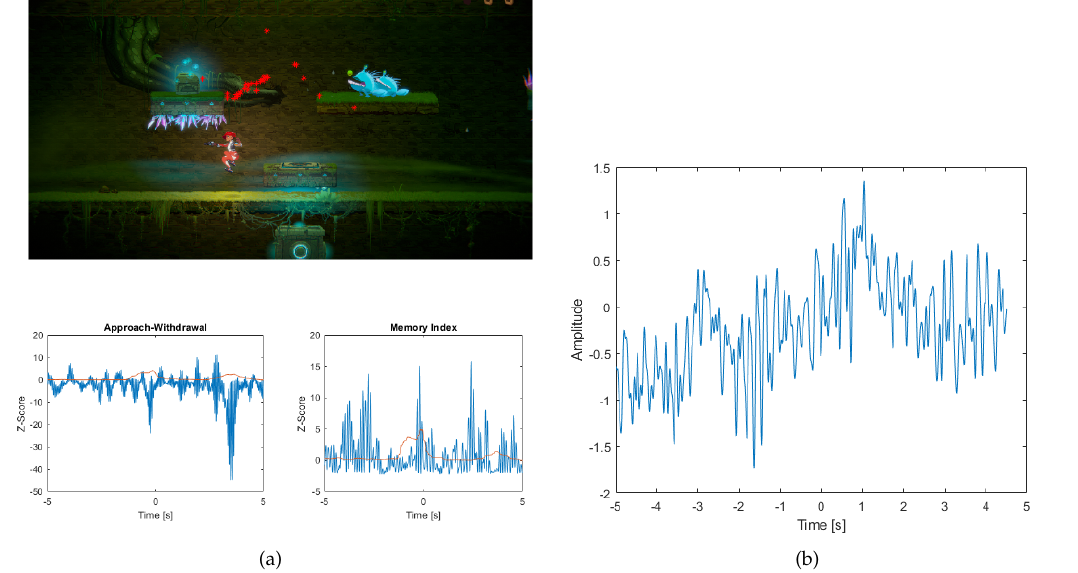
Figure 12. ( a ) The picture shows a screenshot of the game, where the player fights the opponent. In the picture, the points where the player is looking are marked with red stars. Below are the graphs (blue) of the Approach-Withdrawal and Memory Index and the standard deviation value for both indices